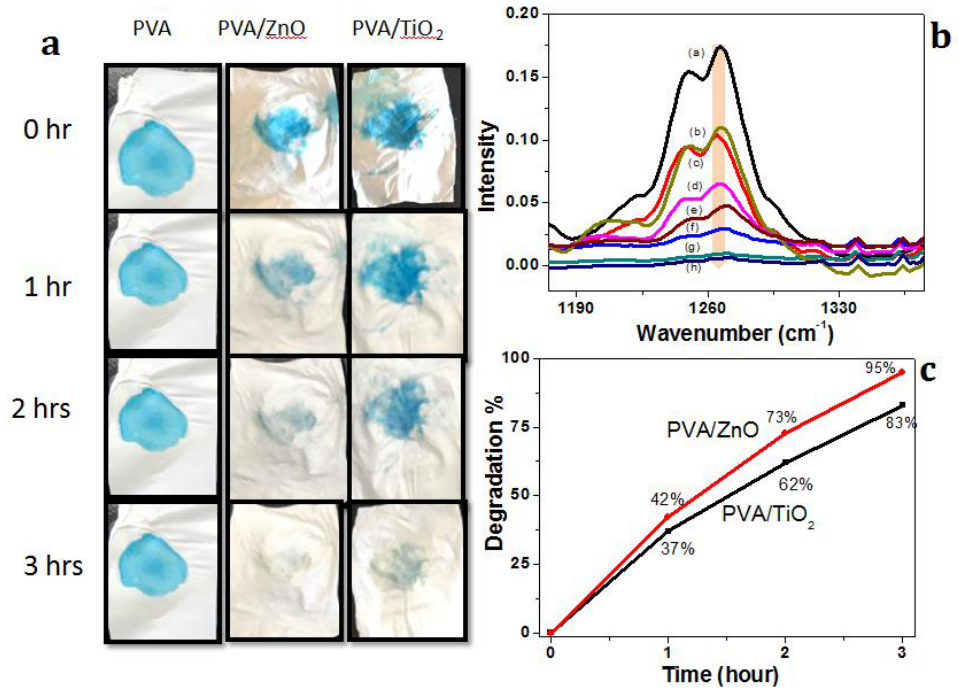
Figure 8. Photo-catalysis efficiency in 3 h of neat PVA nanofibers, 9% PVA/ZnO nanofibers and 9% PVA/TiO 2 nanofibers, ( a ) photocatalytic activity by solar simulator; ( b ) Self-cleaning efficiency calculated by FT-IR; ( c ) profile of self cleaning efficiency of PVA/ZnO & PVA/TiO 2 .